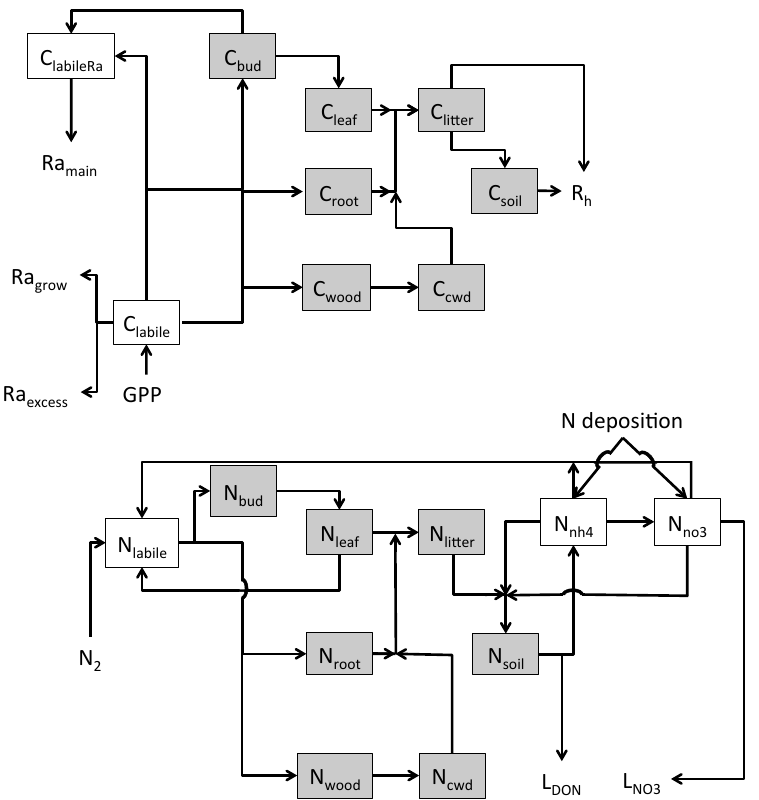
Figure 1. Structure of ACONITE, showing pools (boxes) and fluxes (arrows). The gray boxes are pool with C : N ratios. The top panel shows the C cycle, and the bottom panel shows the N cycle. All pools and flux correspond Tables 1 and 2. R h includes both litter ( t litterC_atm ) and soil C ( t soil_atm ) respiration fluxes. CWD = coarse wood